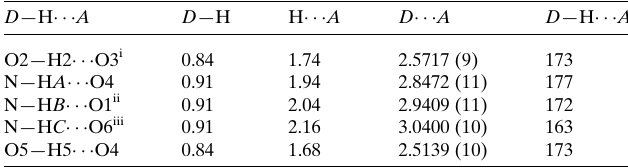
Table 2 Experimental details.